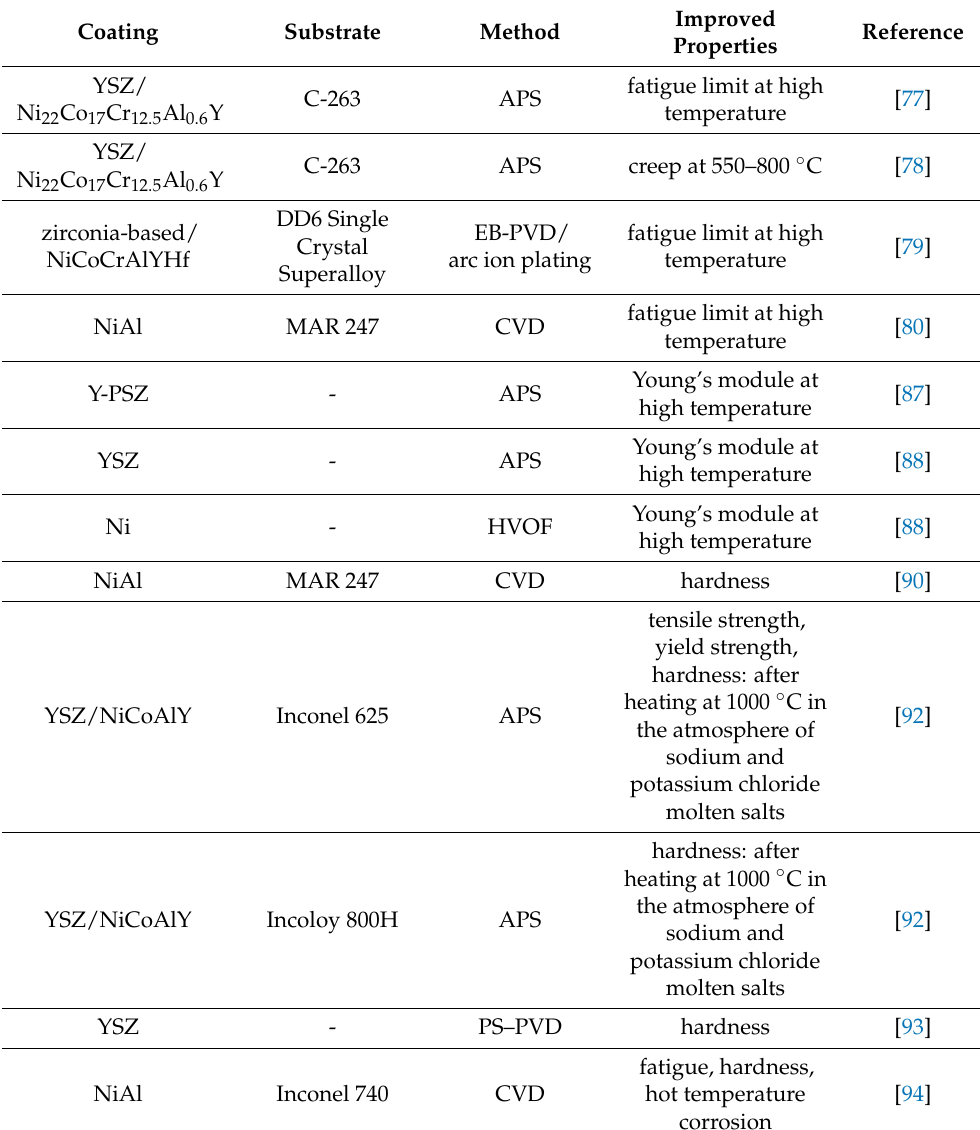
Table 2. Summary of the improved mechanical properties depending on the coating, deposition method and substrate